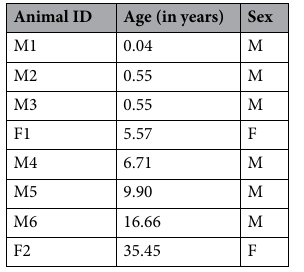
Table 1. Characteristics of the capuchin monkey brains used in the